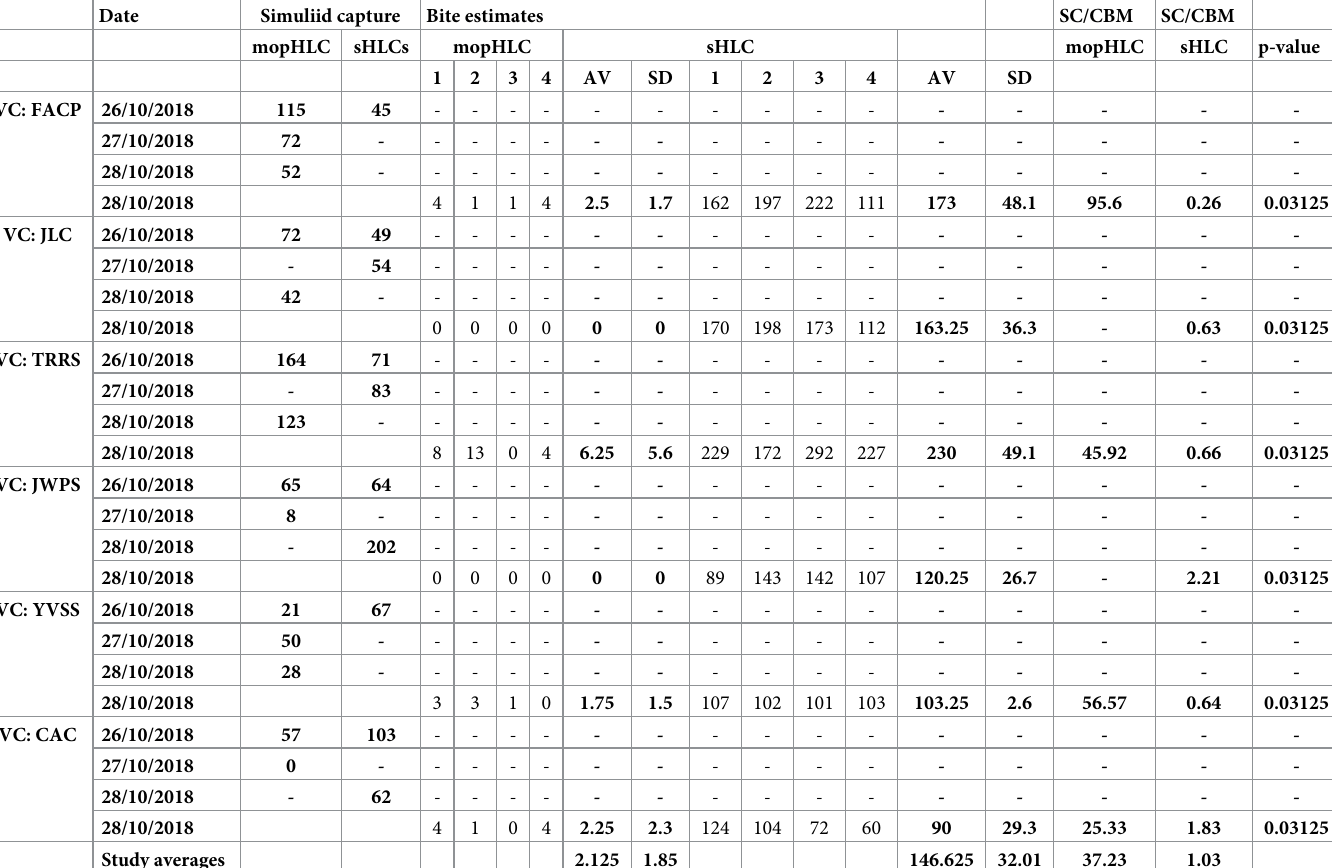
Table 1. Simuliid trapping efficiency and safety data calculated from fresh bite marks and semi-blind bite